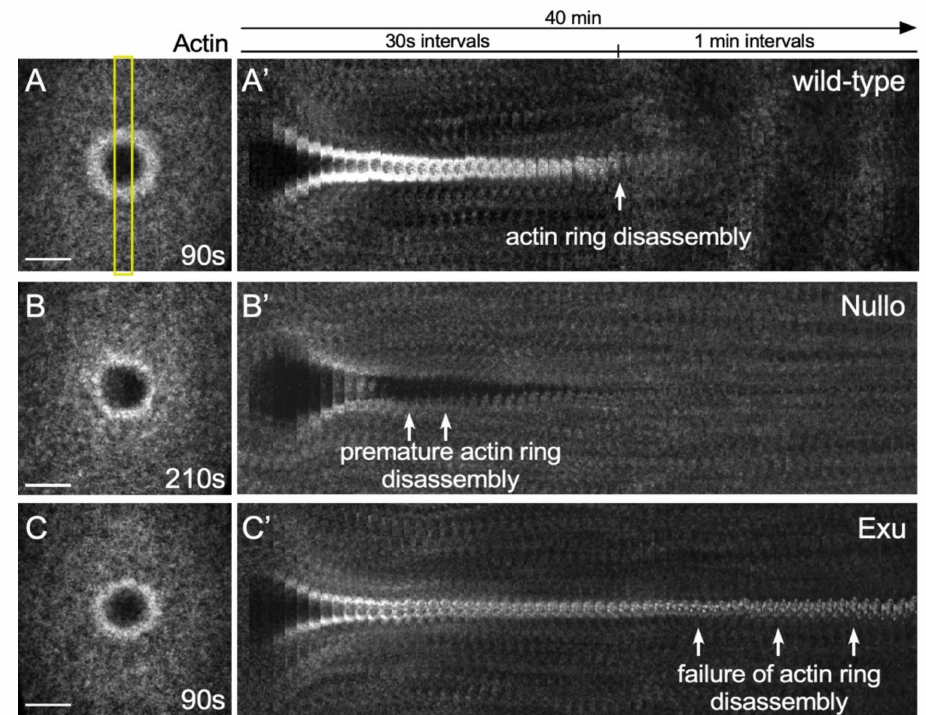
Figure 7. Actin remodeling phenotypes in the Drosophila cell wound model. ( A – C ) XY projection confocal images of NC4-6 laser wounded Drosophila embryos expressing an actin reporter in wild-type ( A ), Nullo RNAi ( B ), and Exu RNAi (C). Yellow rectangle shows region of the image used to generate the kymographs. ( A (cid:48) – C (cid:48) ) XY kymographs generated by cropping (yellow box) XY projection confocal images in A-C and then lining up slices for the 40 min time-lapse. Scale bar: 20 µ